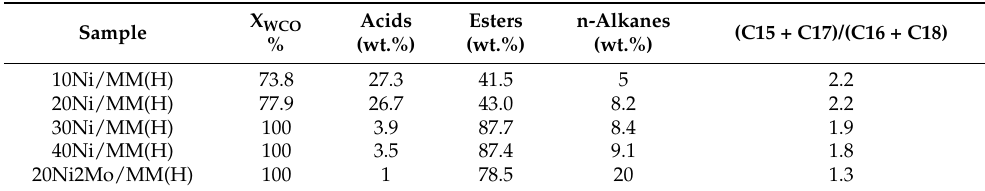
Table 2. Conversion of WCO (% X WCO ) and composition of the liquid mixture obtained upon SDO of WCO at 310 ◦ C for 9 h, over the catalysts